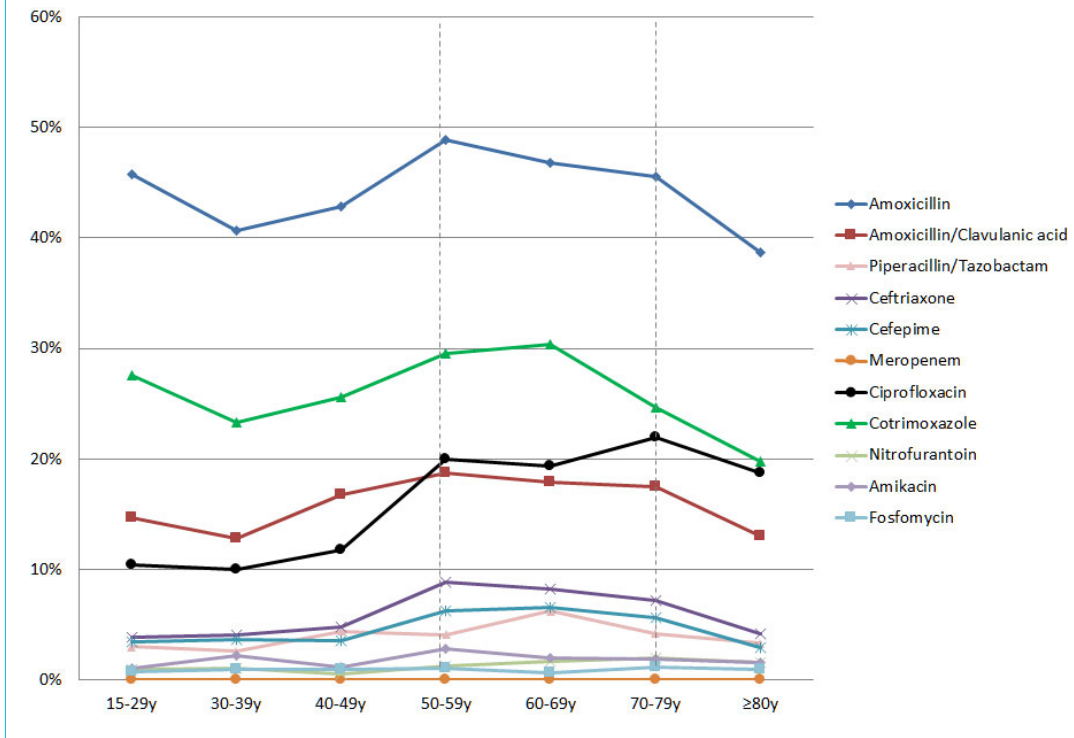
Figure 3: E. coli resistance to various antibiotics stratified by age.y-axis: percentage of resistanceResistance of most antibiotics peaked be- tween the ages of 50 and 79 years (area between dotted lines).